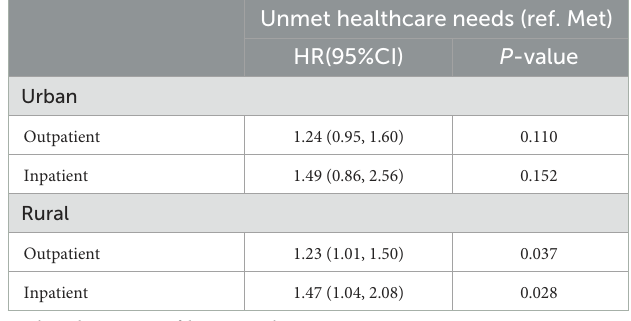
TABLE 5 Subgroup analysis of urban/rural residence ∗